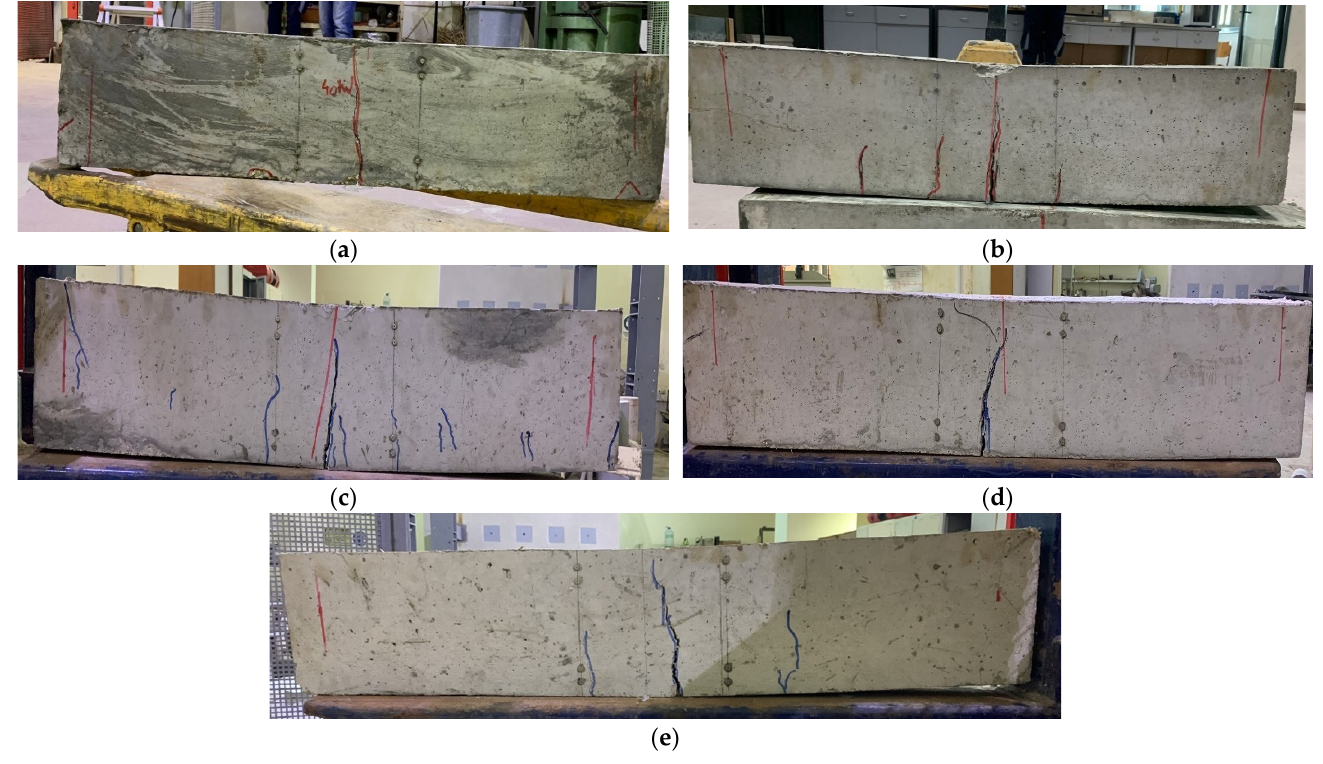
Figure 13. Cracks patterns; ( a ) B1: 0%G, 0%PA; ( b ) B2:10%G, 0%PA; ( c ) 10%G, 0.5%PA; ( d ) = 10%G, 1%PA; ( e ) 10%G, 1.5%PA.